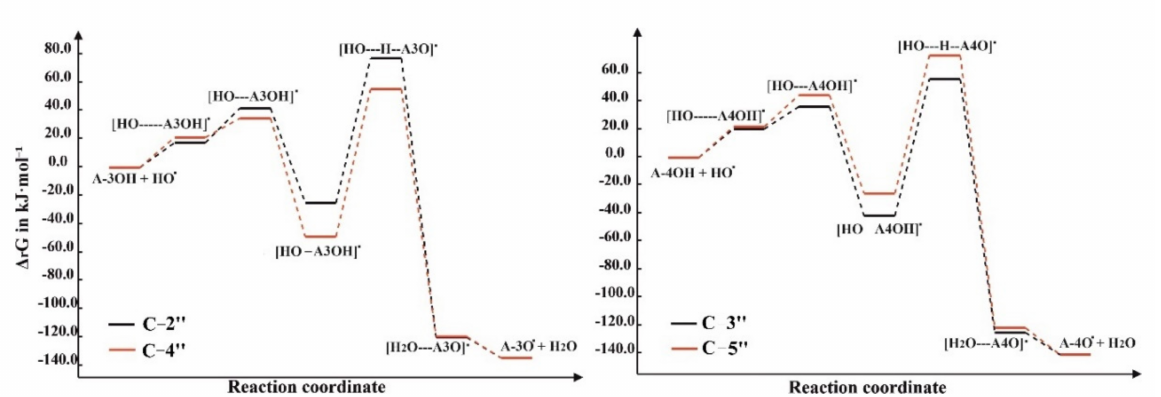
Figure 8. Energy profiles of reactions of A-3OH ( left ) and A-4OH ( right ) with HO • that take place according to RAF followed by the i HAA reaction mechanism.